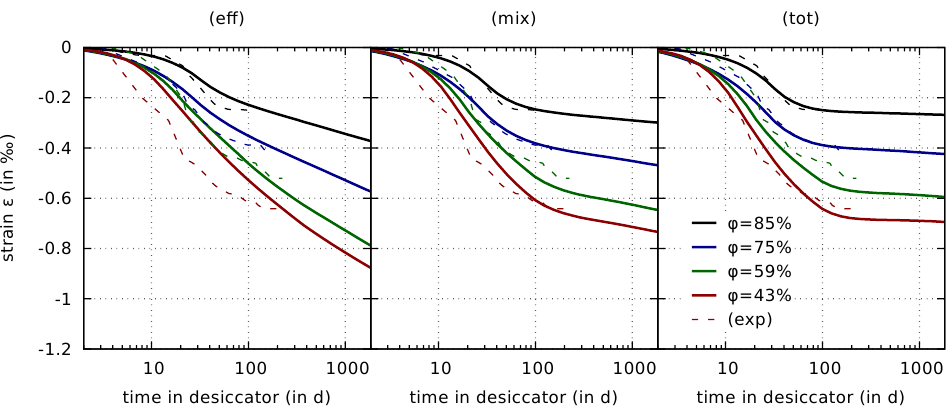
Figure 4. Drying shrinkage strain measured on thin slices [7,8] (exp) for different values of relative humidity ϕ and comparison to computed results on the basis of the three shrinkage and creep formulations: Effective stress formulation (eff), mixed stress formulation (mix), and total stress formulation